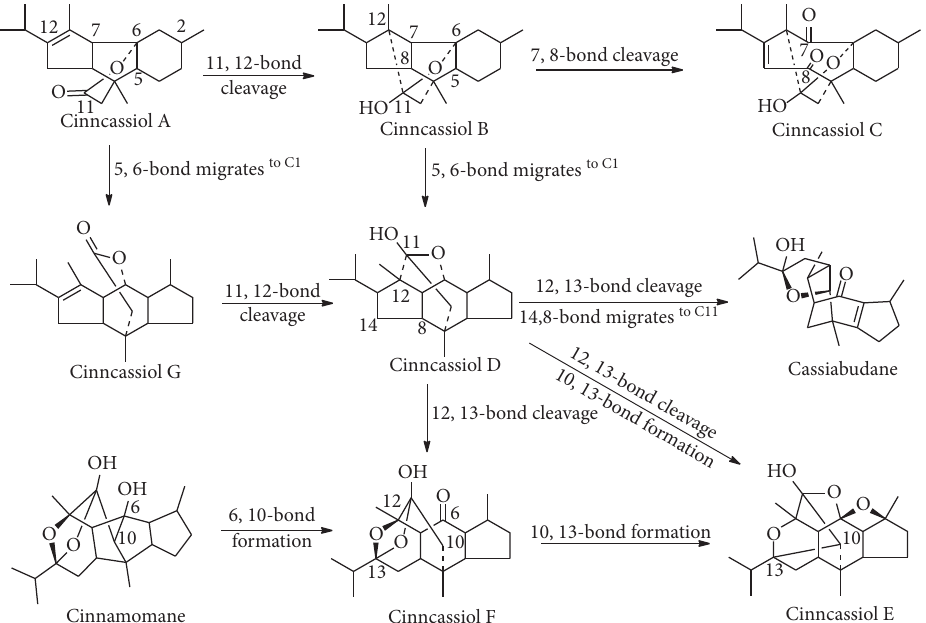
Figure 4: Biogenetic relationships of diterpene carbon skeletons from Cinnamomum .